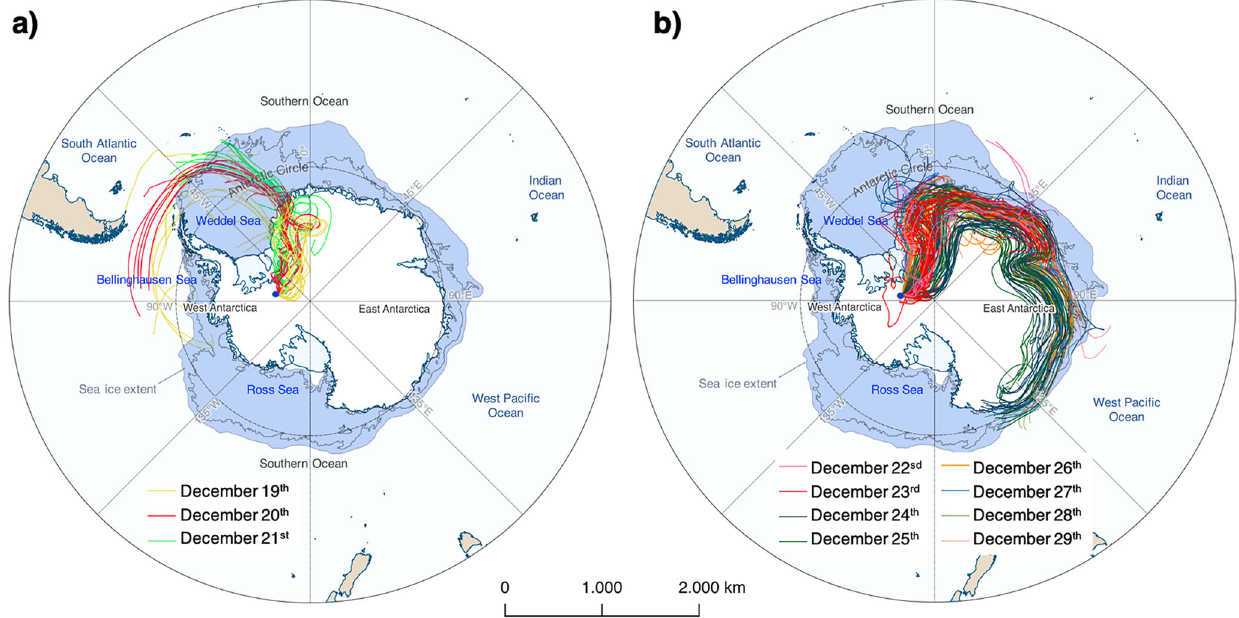
Fig. 1 Air masses backward trajectories. The backward trajectories using the Hybrid Single-Particle Lagrangian Integrated Trajectory (HYSPLIT/NOAA) model with Global Data Assimilation System (see “ Methods ” ) were generated for the aerosol sampling periods of ( a ) December 19th to 21st, 2014; and ( b ) December 22nd to 29th, 2014. The backward trajectories were computed daily at 00:00 UTC at 10 m above ground level with 240-h durations each. The sea ice extent corresponds to the period of aerosol sampling, and the endpoint (blue dot) is the Criosfera 1 lab (84°,00 ’ S; 79°,30 ’ W). All maps were generated using QGIS free software and the Quantartica package from Norwegian Polar Institute